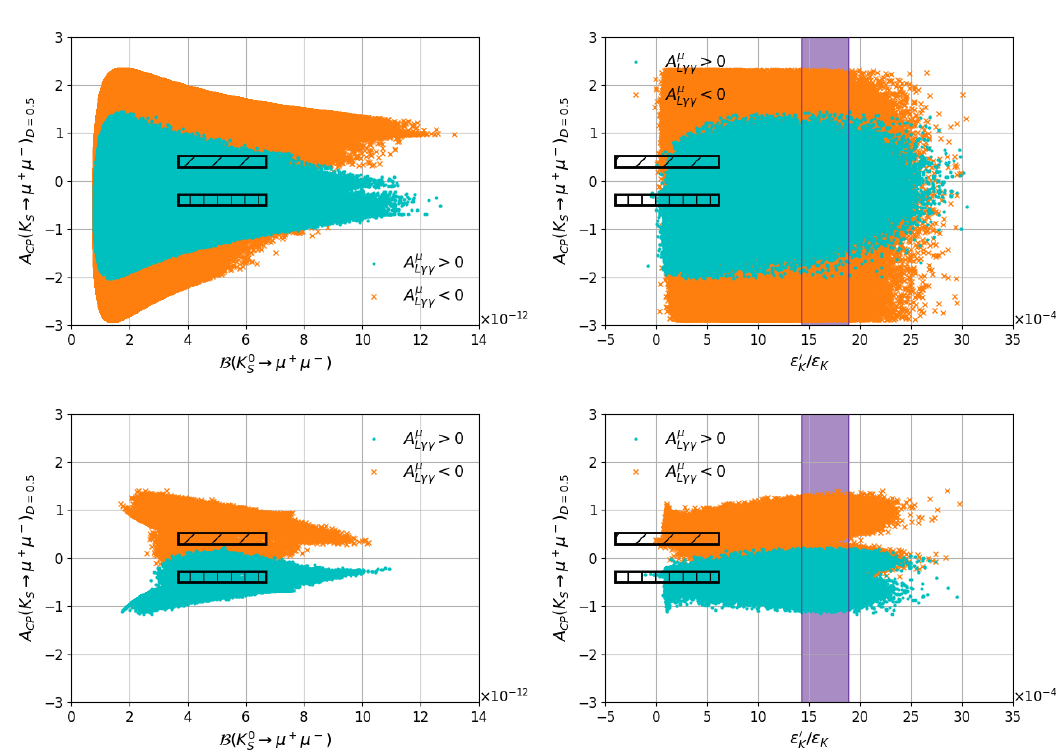
(cid:0) (cid:1) (cid:14) LL 6 = 0 d 12 > 0 L(cid:13)(cid:13) > 0 and the inclined L(cid:13)(cid:13)